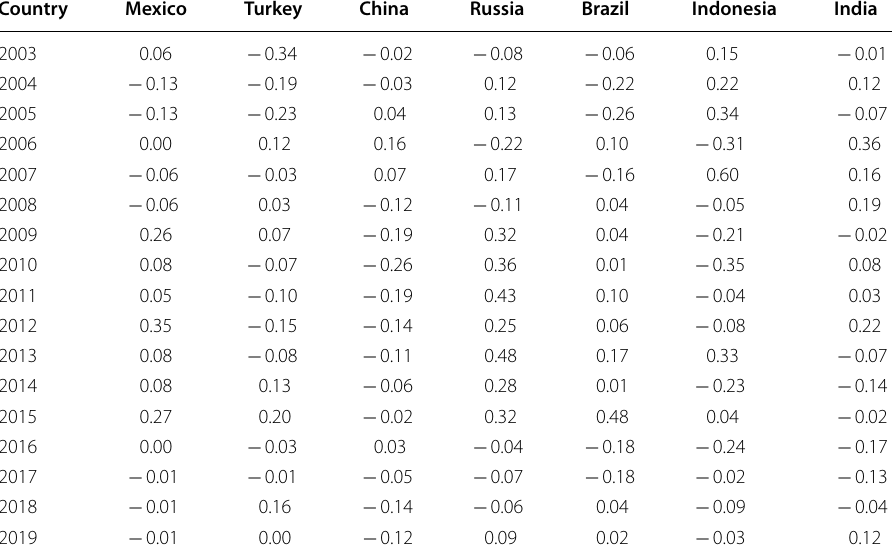
Sources Oxford Economics (2022), author’s calculations